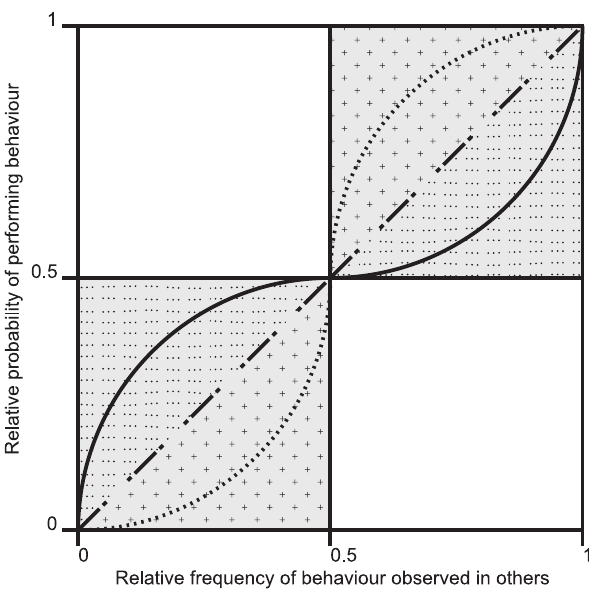
Figure 1. Three different types of conformity. In the shaded domains showing conformity, we distinguish three alternative possibil- ities: (i) weak-conformity (dotted domain, plain line is a possible example); (ii) linear conformity (dash dotted line); and (iii) hyper- conformity (crossed domain, dotted line is a possible example). The non-shaded domains correspond to anti-conformity, in which individ- uals adopt the least frequently observed alternative (after [9]).